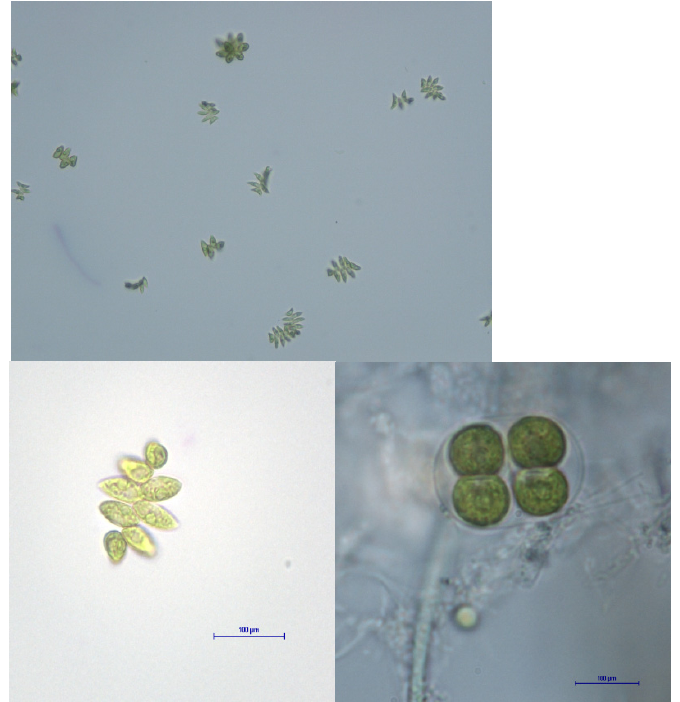
Figure 4. Micrographs by optical microscopy of “ La Orden ” consortium. Species found in the culture medium to magnifications of 20 µm ( above ), 100 µm ( left below ) and 100 µm ( right below ).